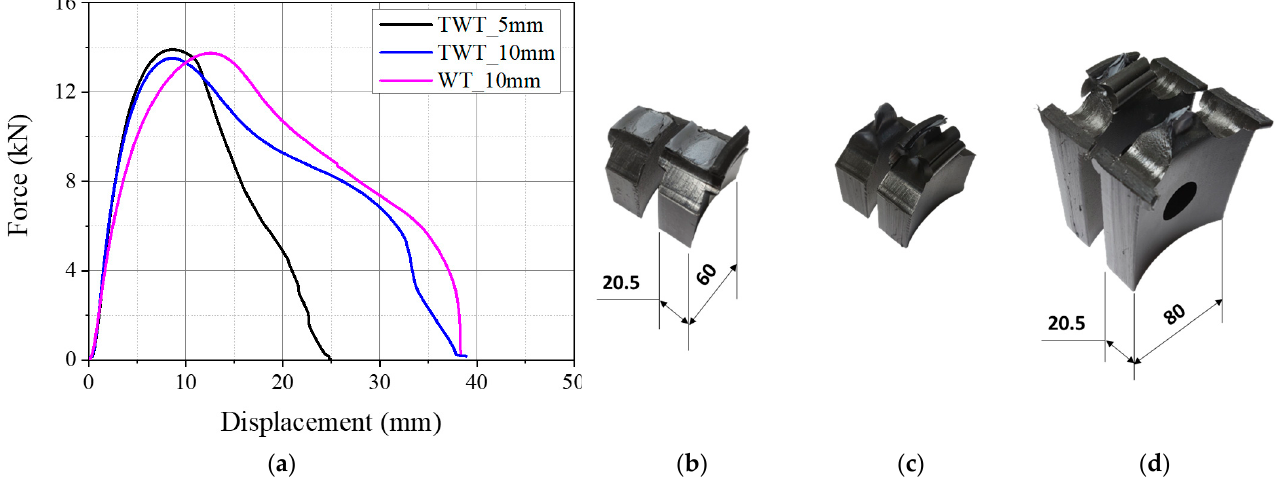
Figure 7. Results of 225 SDR 11 (Type A specimens) pipe BF joint (unit: mm): ( a ) load–displacement curves; ( b ) TWT_5 mm; ( c ) TWT_10 mm; ( d ) WT_10 mm fusion zone notch radius. Table 5. Maximum load and corresponding displacement of Type A, 225 SDR 11 TWT, and WT